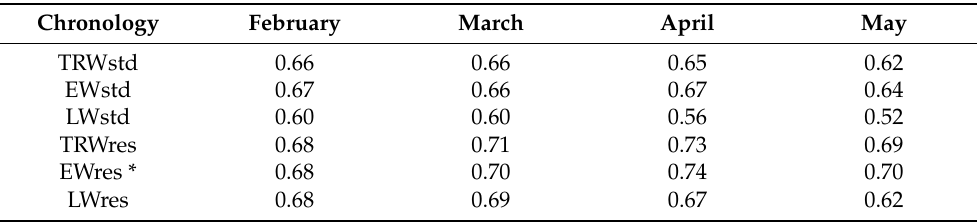
Table 2. Correlation between SPEI values calculated on a 6-month cumulative scale and standard and residual chronologies of Pinus durangensis